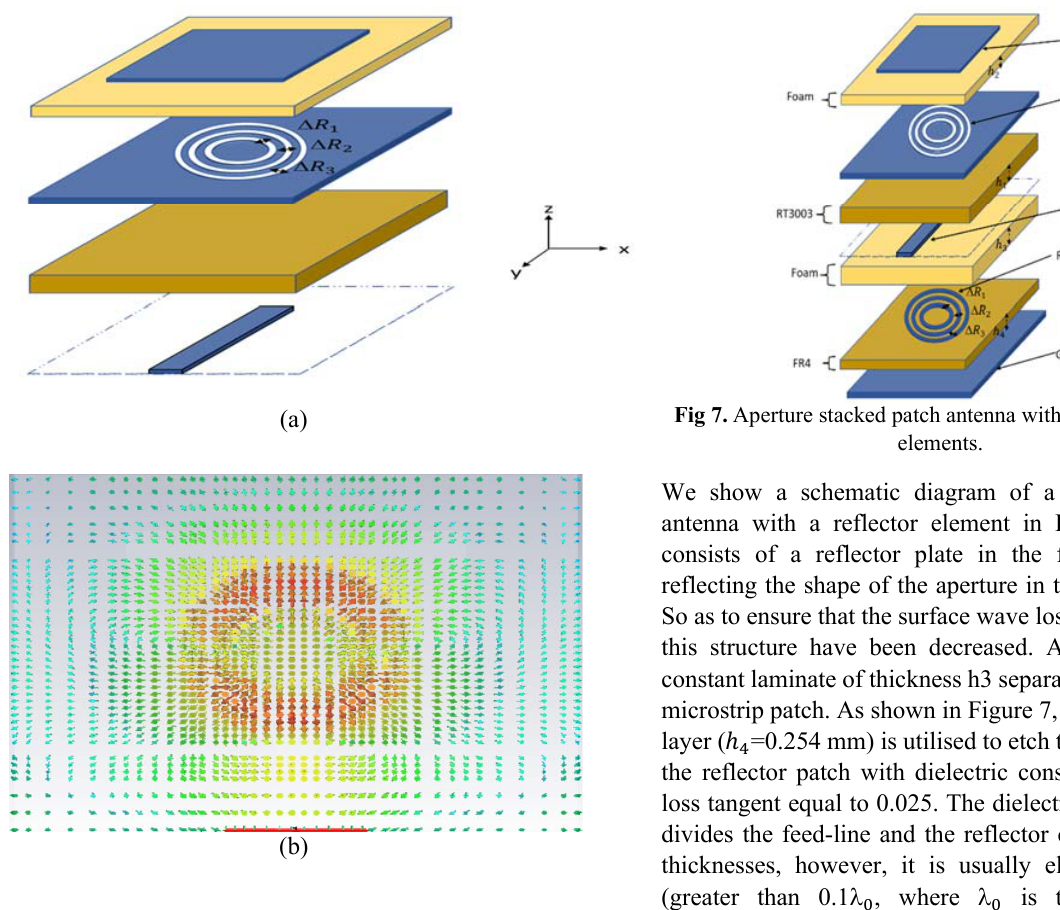
Fig 6. (a) General schematic of the antenna with three slot couplings in the form of circles, (b) Current distribution through the slots